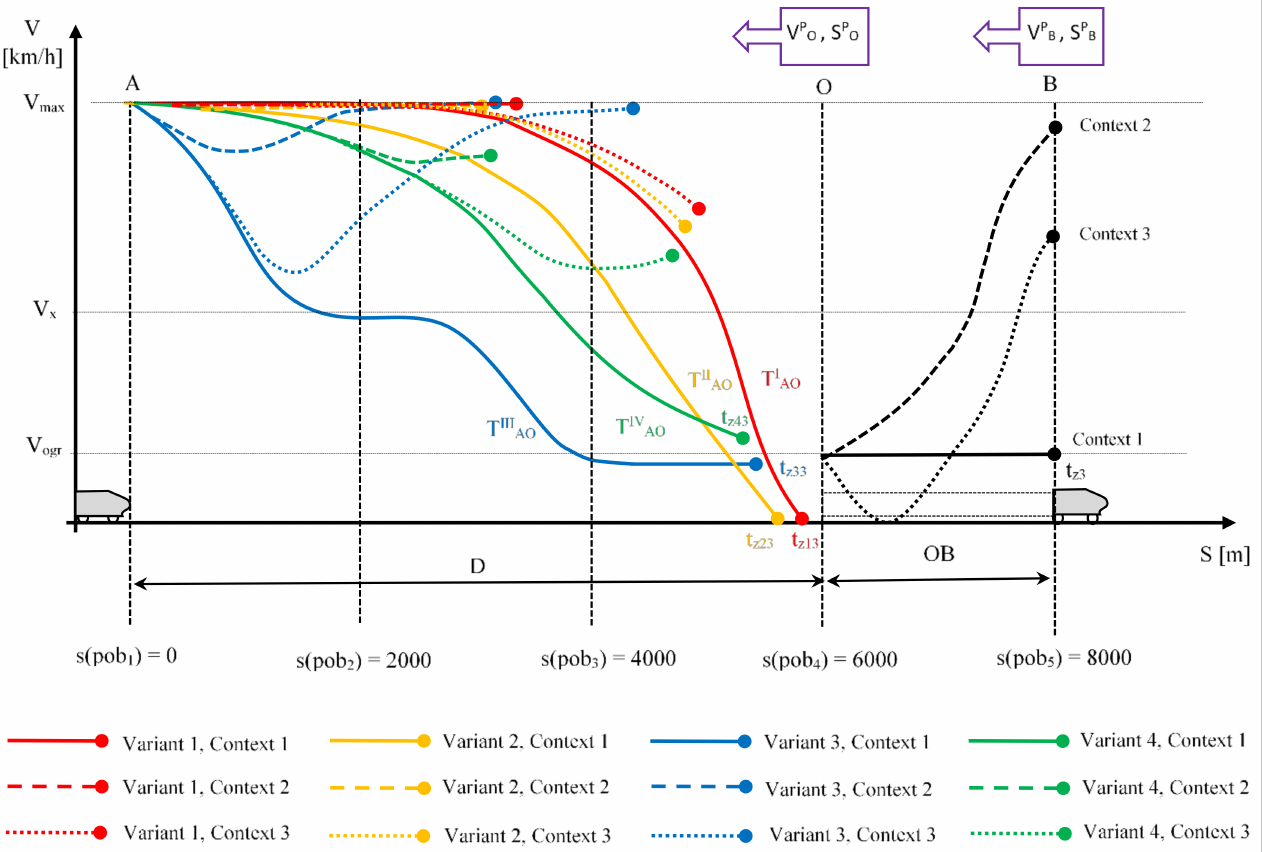
Figure 6. Adopted speed profiles for the Context P P and Variants P N (source: own